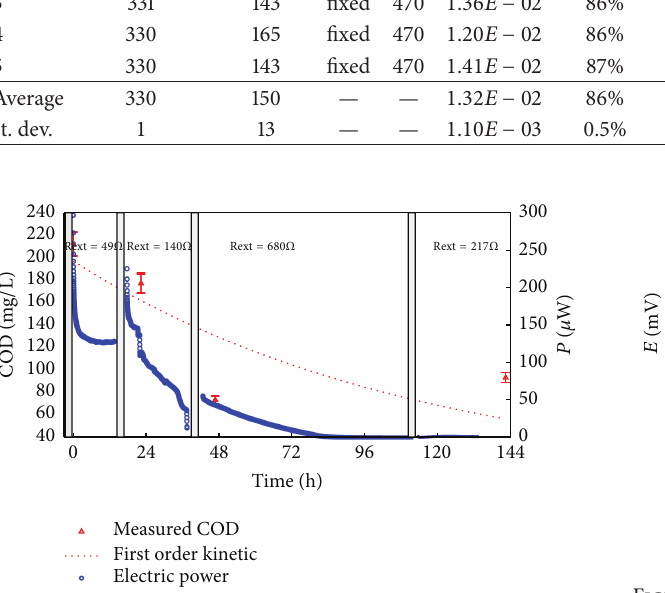
Table 5: MFC feeding with SW2 wastewater. Continuous monitoring results and bioelectrochemical performances calculation. T.C.